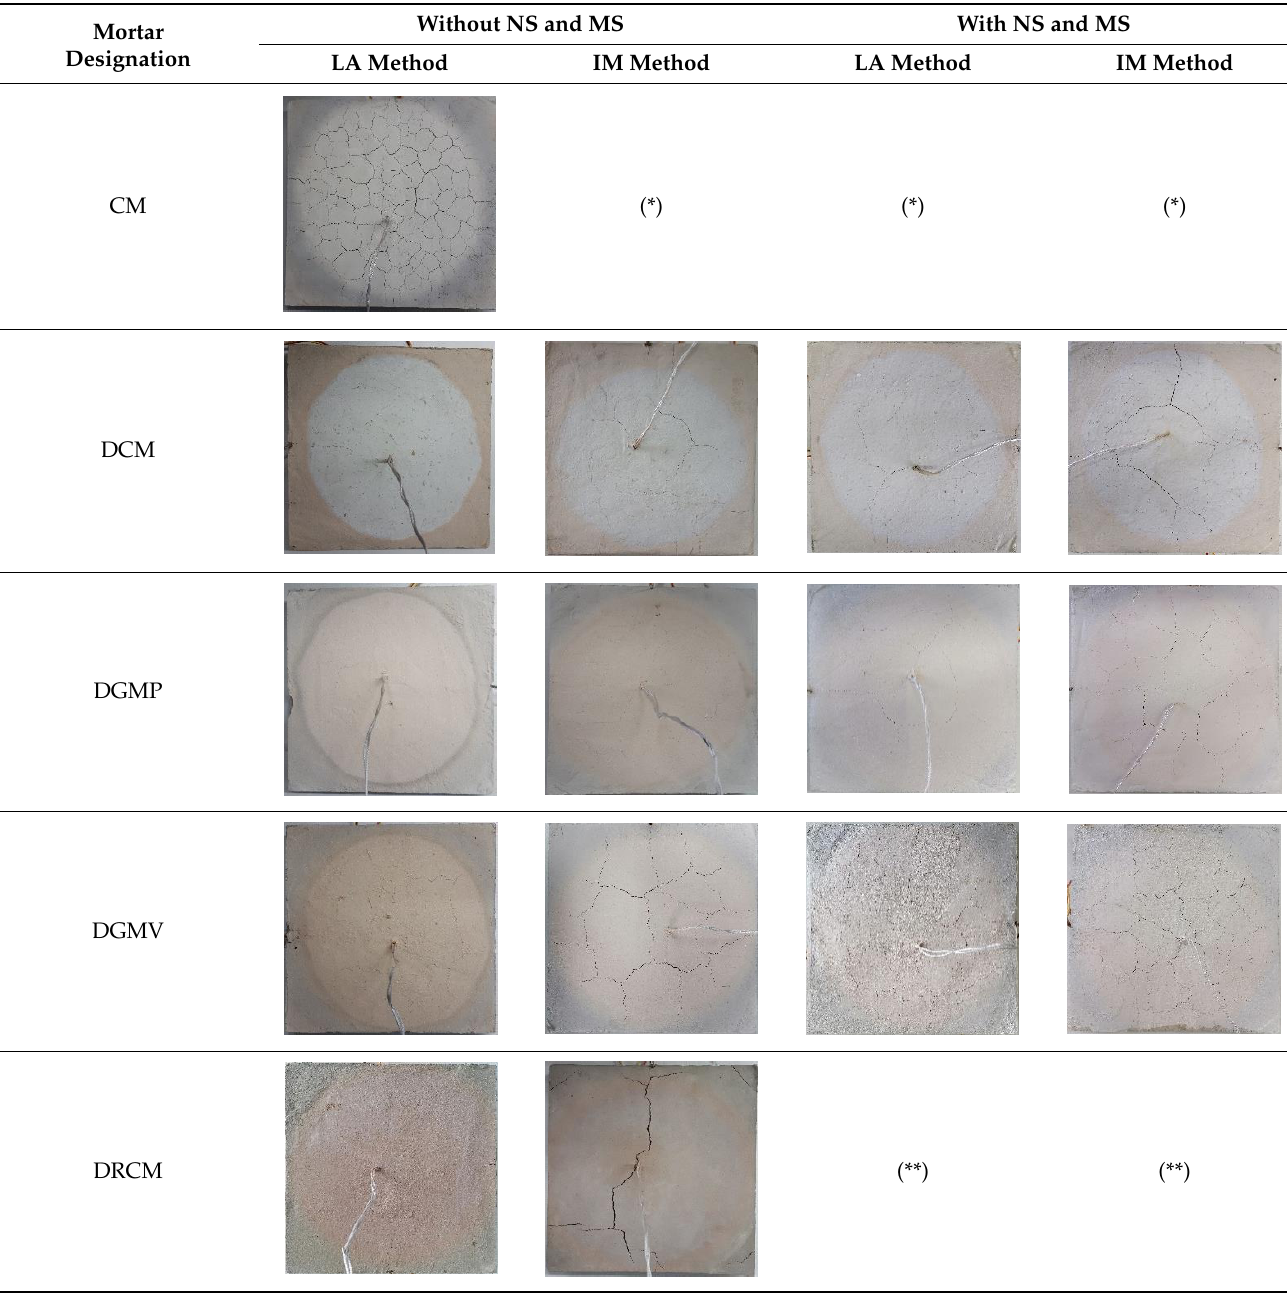
0200400600800 0200400600800